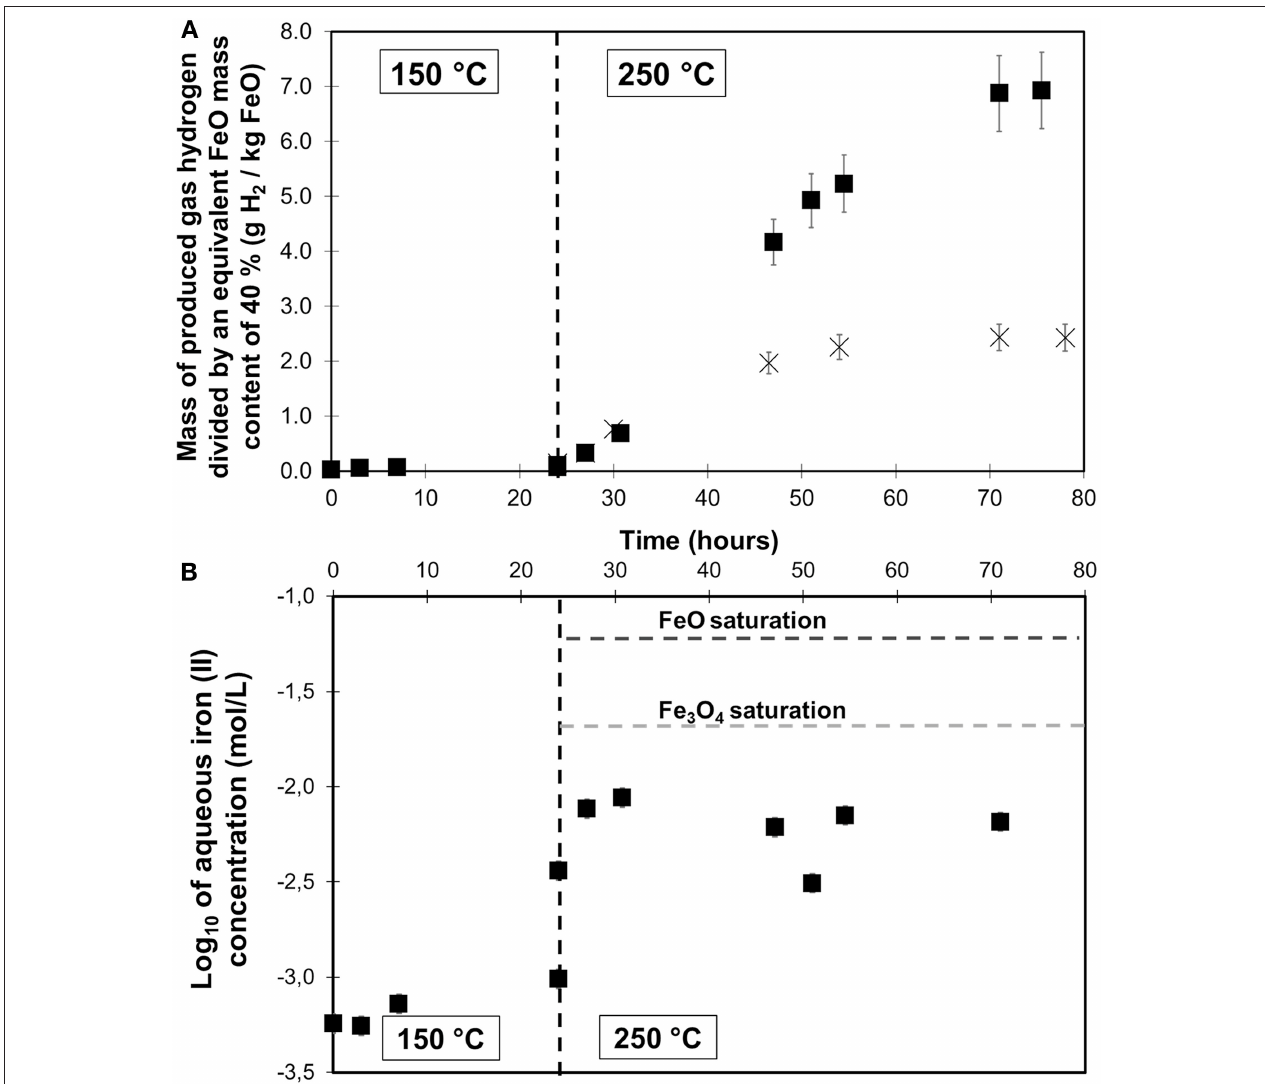
FIGURE 7 | Time-resolved monitoring of (A) the H 2 gas production (squares) and (B) the ferrous concentration of the hydrothermal oxidation of decalcified steel slag from 150 to 250 ◦ C at 180 bar in presence of 1M acetic acid ( APAc-1M-250C ). H 2 gas production was monitored in a previous run performed under the same working conditions but without steel slag sample (crosses). Hydrogen production data were normalized to an equivalent FeO content of 40%, i.e., in accordance with µ XRF analysis on calcium depleted sample. Fe 2 + concentration at saturation were calculated using PhreeqC with llnl.dat database under the conditions of the experiment. At 150 ◦ C, Log 10 (Fe 2 + , aq , mol/L) at saturation were found to be equal to − 0.4 for FeO and − 0.6 for Fe 3 O 4 and are not